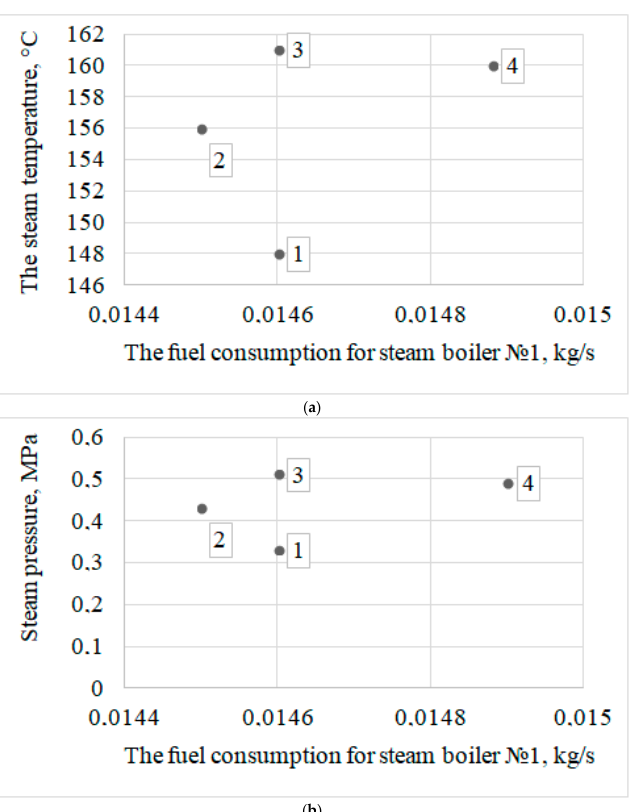
Figure 10. Relationship between parameters in Steam boiler 1: ( a ) relationship between steam temperature and fuel consumption, ( b ) relationship between steam pressure and fuel. The correlation coefficient showing the relationship between steam temperature and fuel consumption, as well as the relationship between steam pressure and fuel con ‐ sumption for steam boiler 1 in the second mode is 0.2306 and 0.2352, respectively. Points 1 and 3 illustrate that with a large difference in vapor pressure, the fuel consumption changed by a small value Δ B = 0.00006 kg/s. A small drop in fuel consumption is associ ‐ ated with a sharp increase in the temperature of the feed water, Δ t = 8 °C (18). The in ‐ crease in the temperature of the feed water reduced the boiler’s need for higher fuel consumption to maintain steam parameters (27):